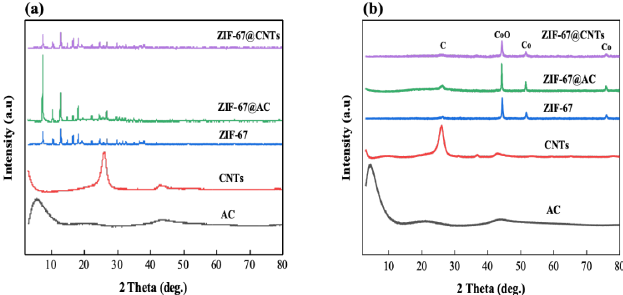
Figure 3. XRD patterns of various samples ( a ) before heating treatment and ( b ) after carbonization at 900 °C.